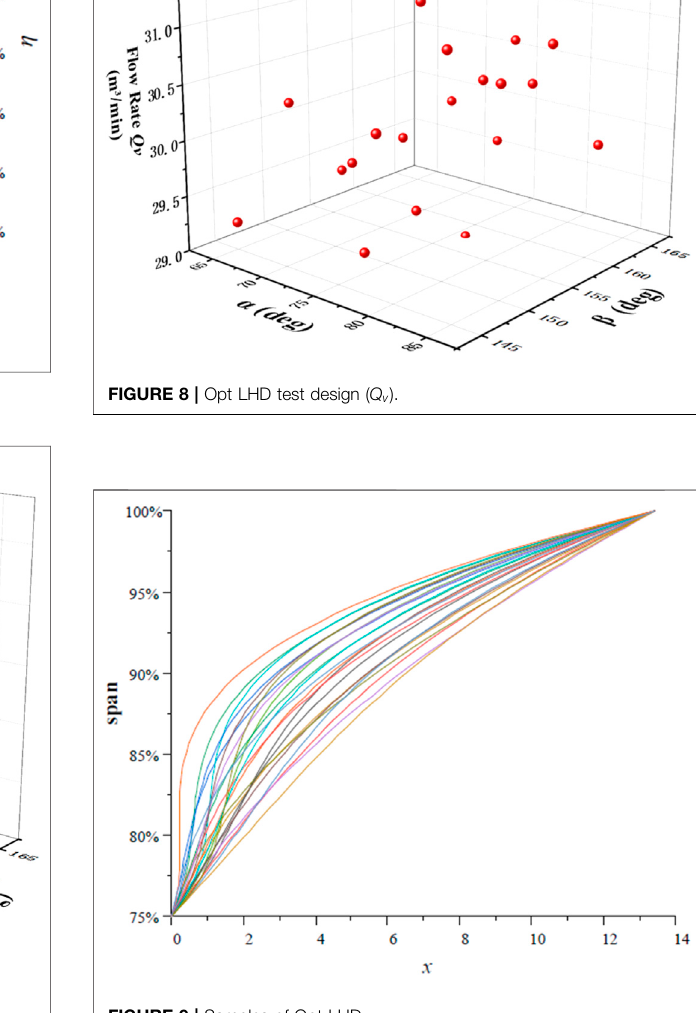
FIGURE 9 | Samples of Opt